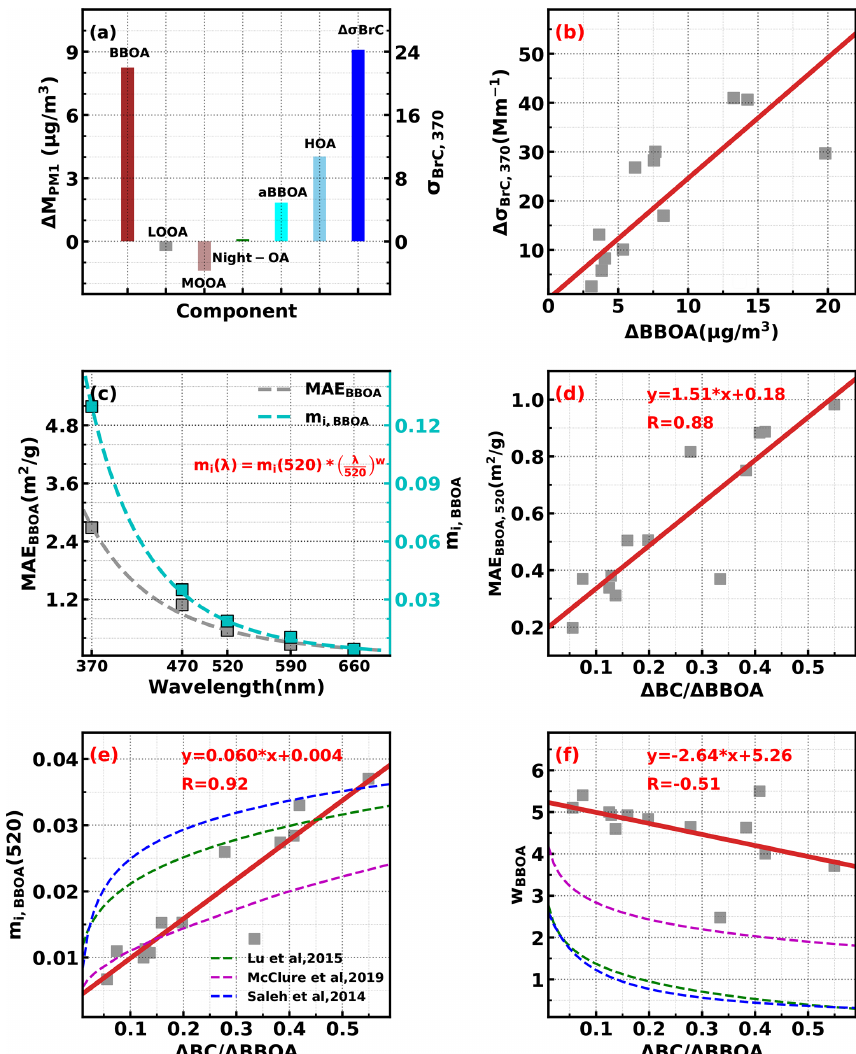
Figure 5. (a) Average changes in organic aerosol components for BBOA spikes when BC measurements are available. (b) Relationships between derived (cid:49)σ BrC at 525nm only associated with BBOA and (cid:49) BBOA. (c) Average spectral dependence of MAE BBOA and m i , BBOA . (d) Relationship between MAE BBOA at 525nm and (cid:49) BC /(cid:49) BBOA. (e) Relationship between m i , BBOA at 520nm and (cid:49) BC/ (cid:49) BBOA. (f) Relationship between the spectral dependence parameter w BBOA and (cid:49) BC /(cid:49)